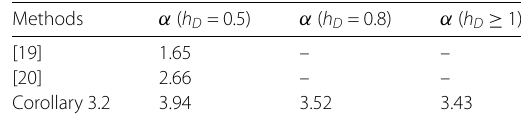
Table 1 The maximum upper bound of α when τ m = 0.5, τ M = 2.0 in Example 4.1